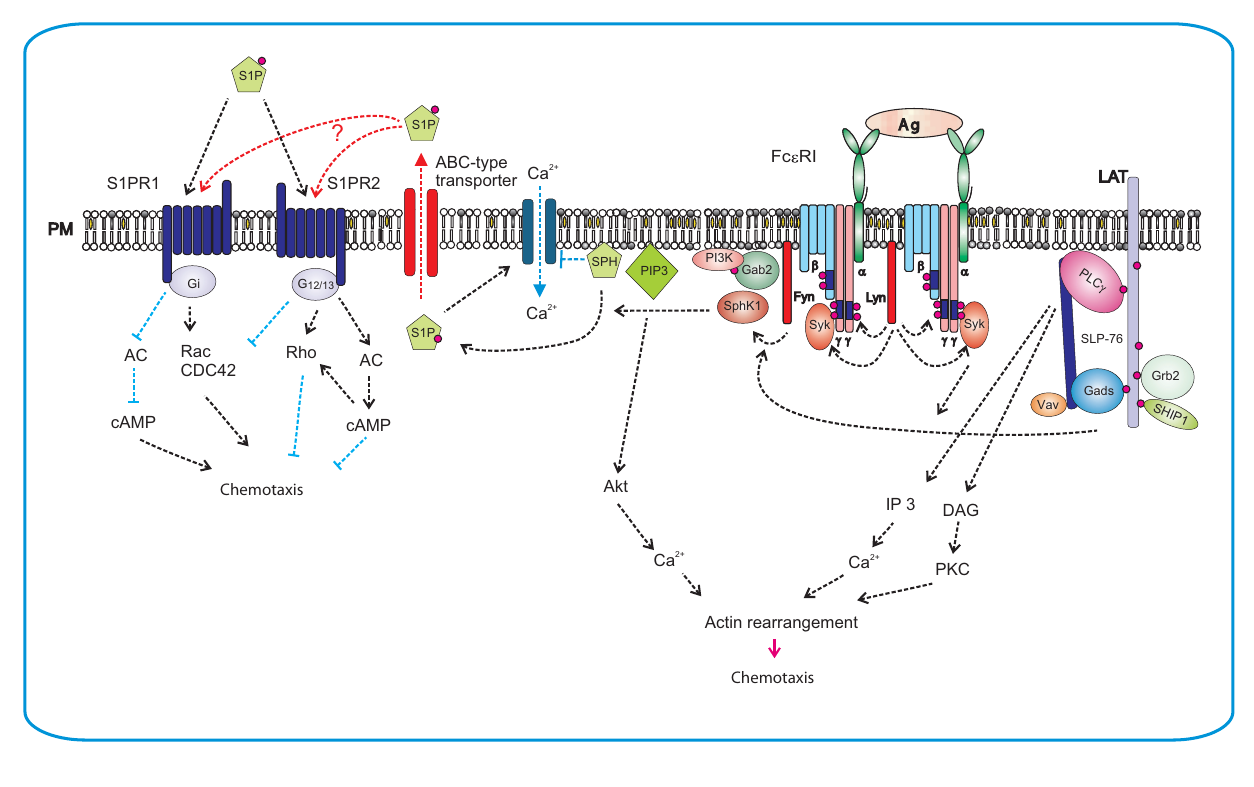
FIGURE 3 | Production of S1P after Fc ε RI triggering and S1P-mediated chemotaxis. Fc ε RI triggering leads to rapid activation of Lyn and Fyn kinases and Lyn-mediated phosphorylation of tyrosine residues of ITAM motifs in Fc ε RI β and γ subunits.This is followed by anchoring of Syk to Fc ε RI and enhanced enzymatic activity of Syk. Lyn kinase interacts directly with SphK1 and recruits it to the proximity of Fc ε RI, whereas Fyn kinase mediates the recruiting of Gab2 and PI3K to the membrane and foster in this way the activation of SphK1. Phosphorylation of sphingosine (SPH) by SphK1 leads to S1P formation. Sphingosine is an inhibitor of SOC channels. Formation of